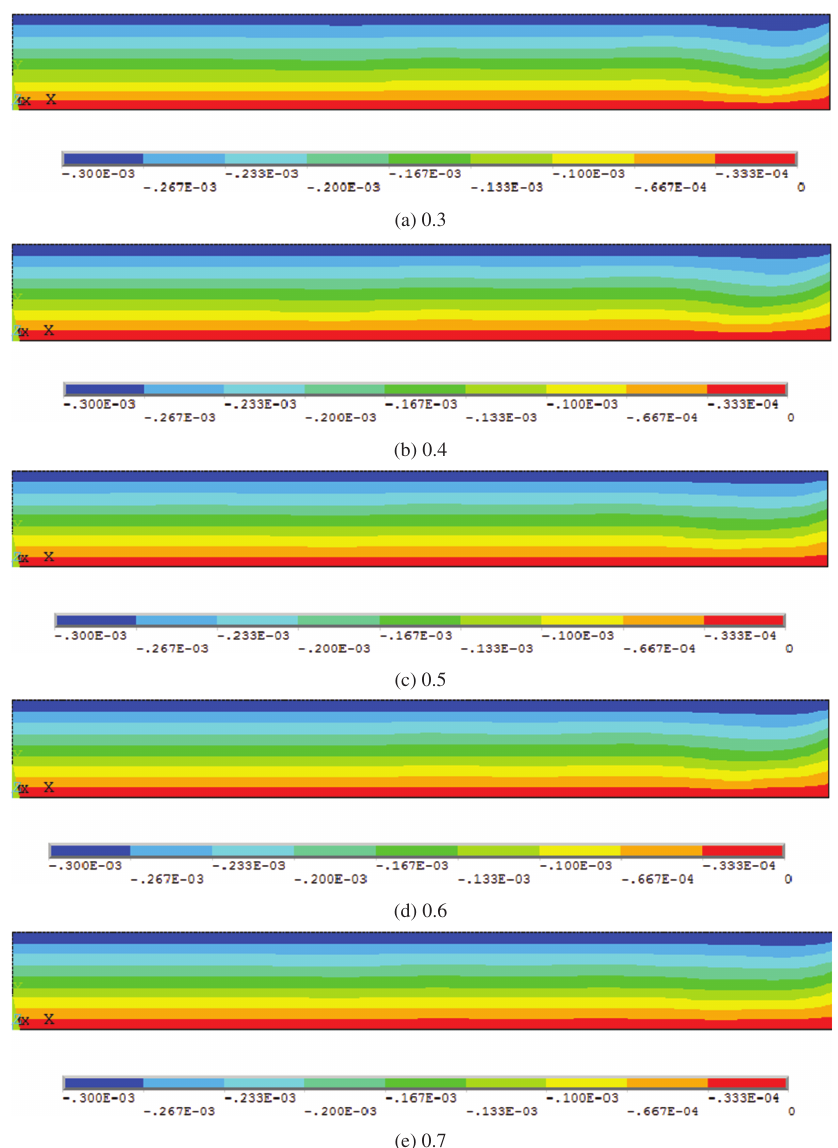
Figure 7: Displacement nephogram along thickness direction of slab under different solid phase